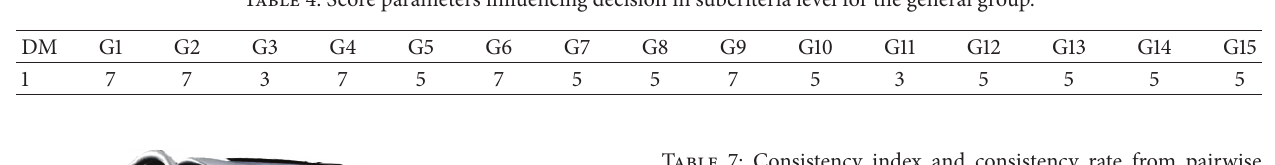
Table 7: Consistency index and consistency rate from pairwise